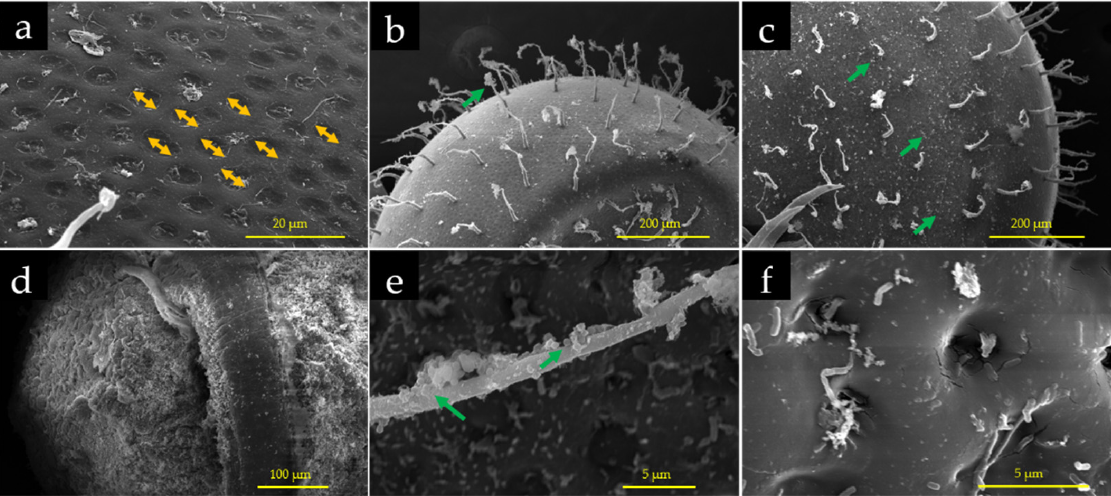
Figure 3. SEM images of different parts of O. melastigma embryos at 6 dpf after PS-MP exposure. ( a ) Membrane pores (from outside the membrane); ( b , e ) villus on membrane surface under different resolutions; ( c ) chorion of embryo; ( d ) spinal cord of larvae; ( f ) membrane pores (from inside the membrane). Yellow bidirectional arrows in the image indicate the position and sizes of the membrane pores, whereas green arrows indicate the PS-MPs found on the villi or membranes of the embryos.